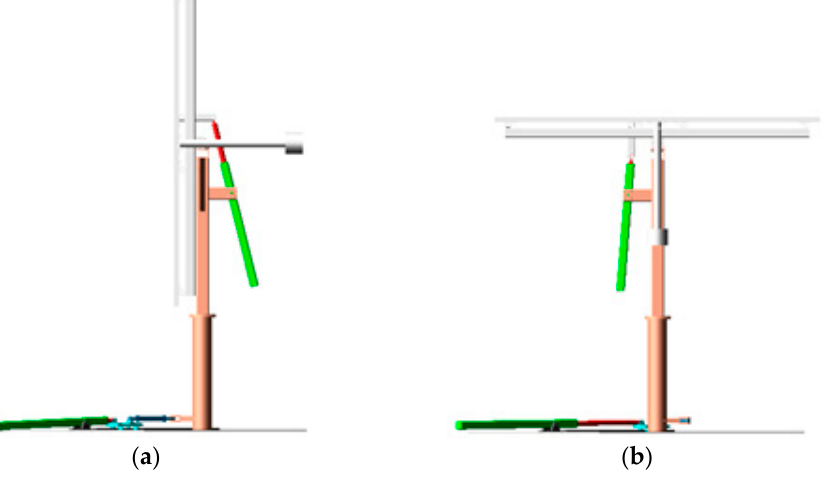
Figure 6. End (limit) positions of the tracking system/platform: ( a ) ψ * = 90 ◦ , α * = 0 ◦ ; ( b ) ψ * = − 90 ◦ , α * = 90 ◦